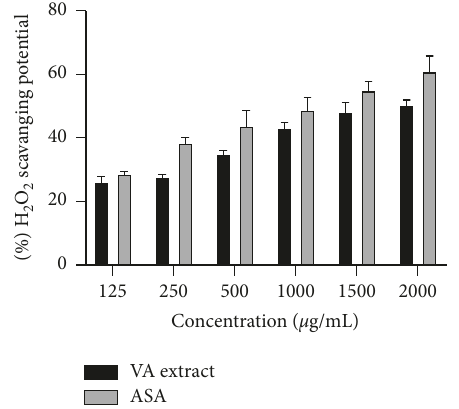
Figure 3: % H 2 O 2 radicals scavenging potential of V. album extract and Ascorbic